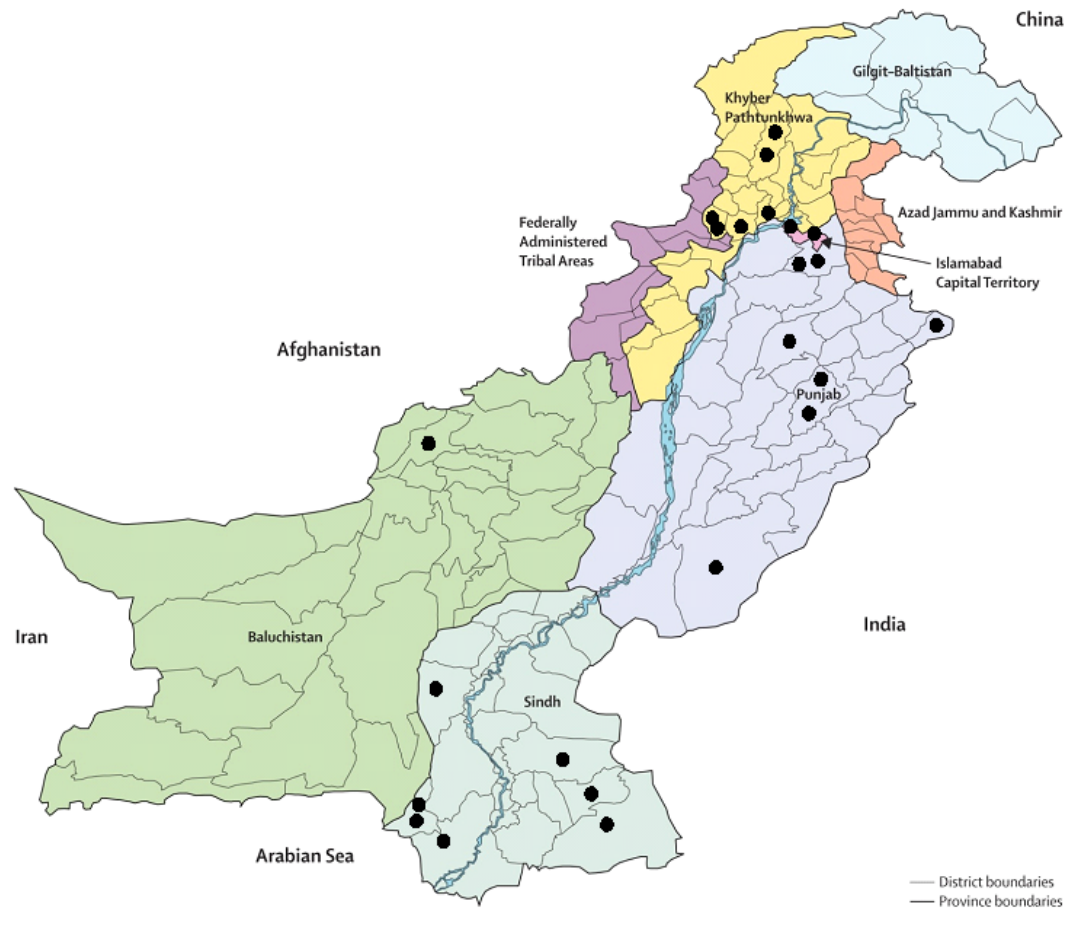
Figure 2. Coverage of geographical areas in the studies reviewed. The total number does not equal the total number of studies as certain studies focused on more than one area.